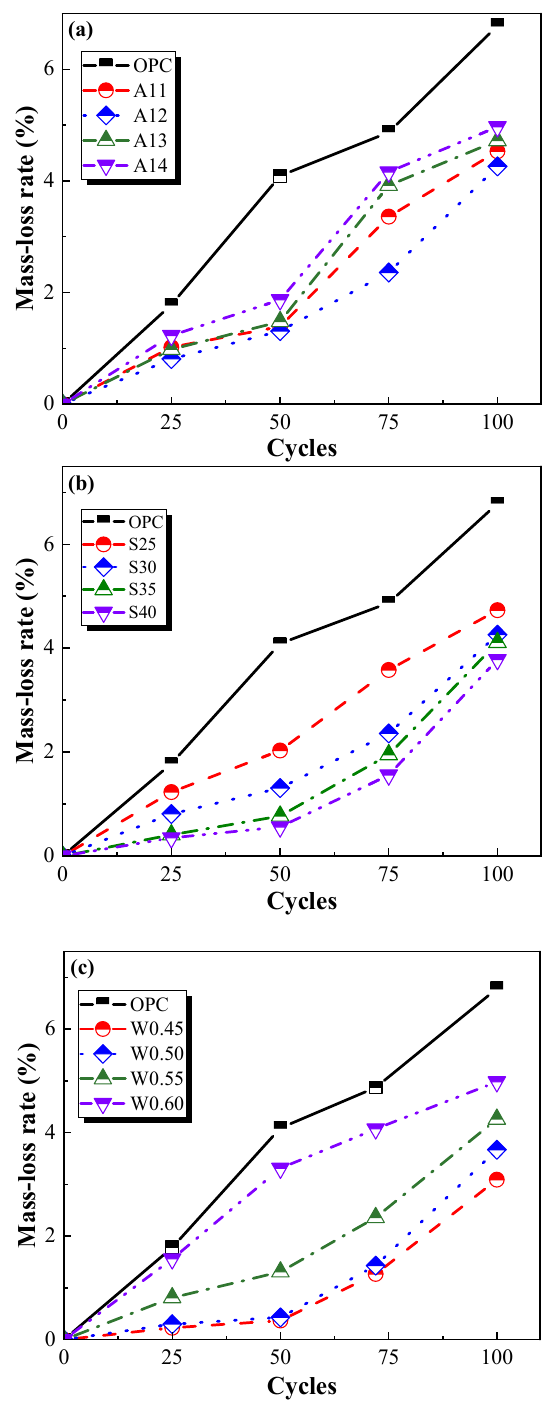
Figure 4. Mass-loss rates of specimens: ( a ) alkali content; ( b ) slag content; ( c ) water-to-binder ratio.